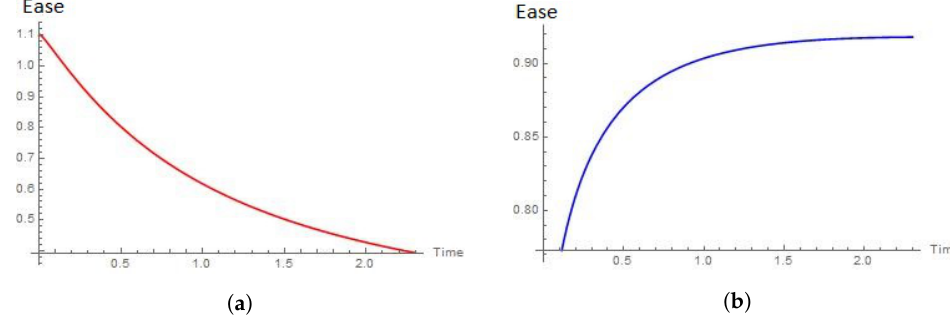
Figure 16. Ease of the extraction when the shape parameters of Weibull and Chen distributions are δ 1 = 2 and δ 2 = 1 , respectively. ( a ) Ease of the extraction for Weibull’s player when δ 1 = 2. ( b ) Ease of 2 the extraction for Chen’s player when δ 2 = 1 . 2